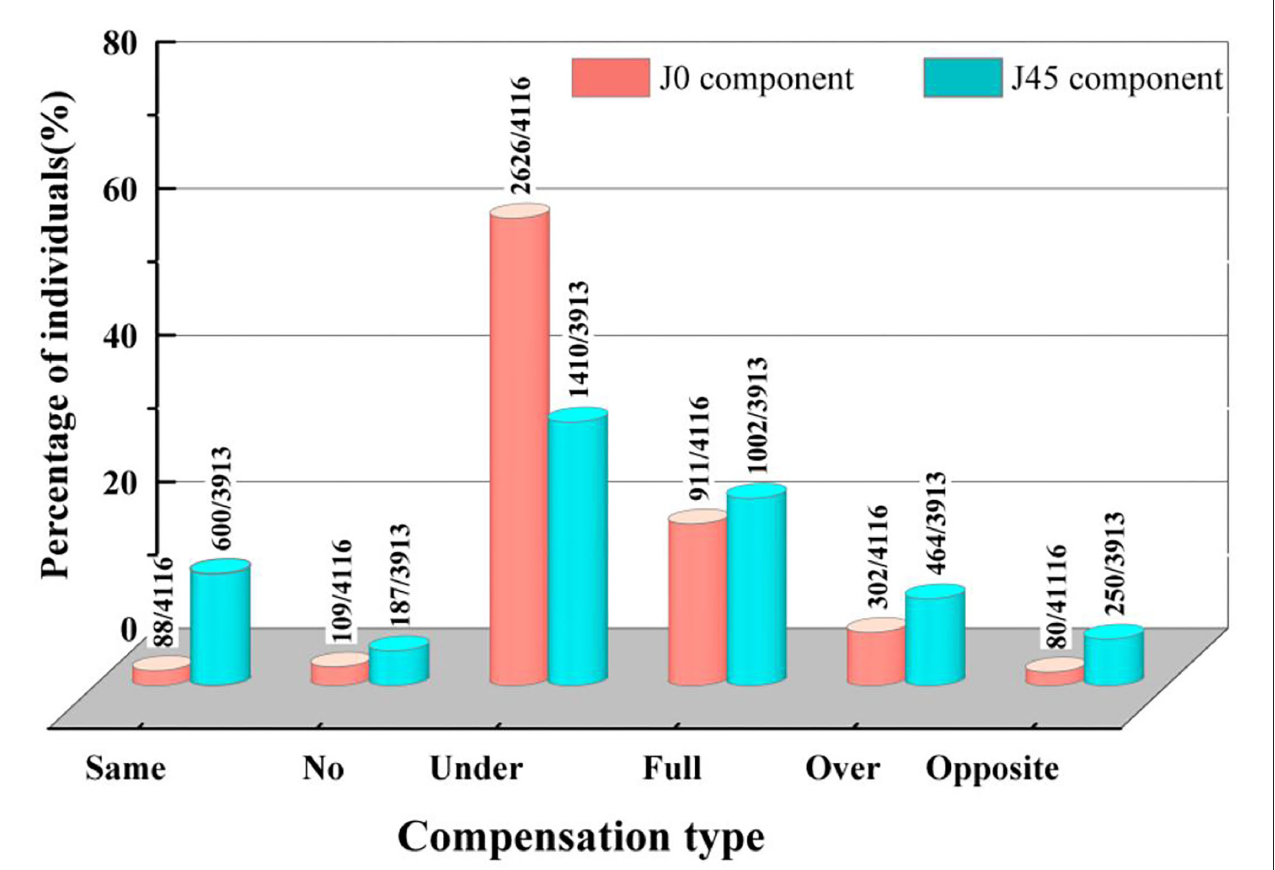
FIGURE2 Distribution of compensation factor types in J0 and J45 components. J0 and J45 components represent the orthogonal (power of Jackson cross cylinder at 90 ◦ and 180 ◦ ) and oblique (power of the Jackson cross cylinder at 45 ◦ and 135 ◦ ), respectively. The percentage of compensation types in J0 , J45 components are shown on the y-axis. The groups of compensation types are shown on the x-axis. (1) Same: same axis augmentation; (2) No: no compensation; (3) Under; under compensation; (4) Full: full compensation; (5) Over: over compensation; (6) Opposite: opposite axis augmentation.